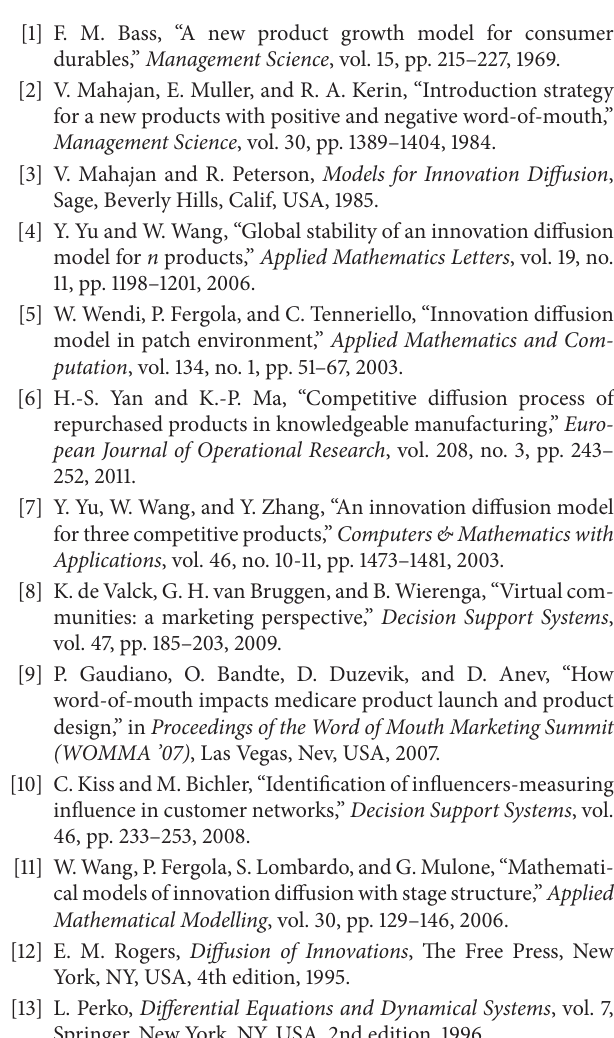
Figure 3: Time series of 𝑎(𝑡) with changes of 𝛼 .